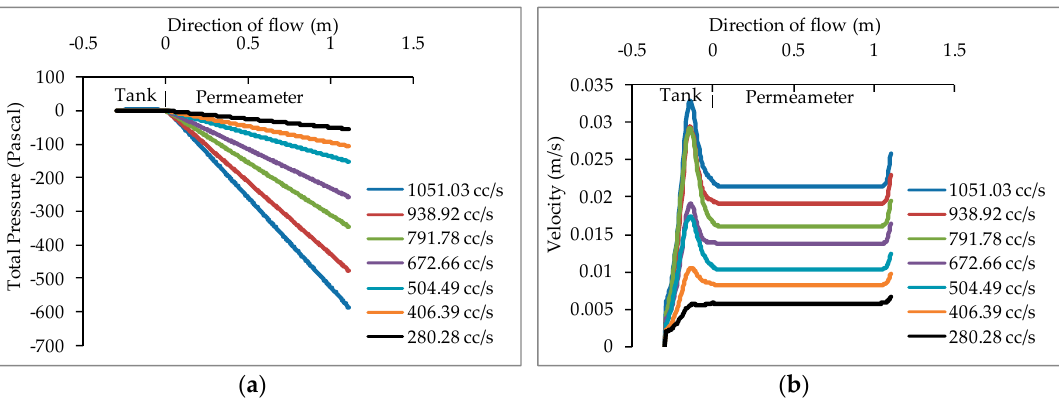
Figure 7. The values of ( a ) the total pressure and ( b ) the velocity in the direction of the flow subjected to different discharges for 34.78 mm media packed with 44.70% porosity.